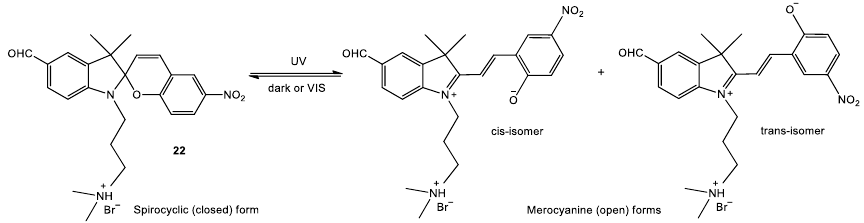
Figure 3. Spiropyran (SP) closed-ring structure and its stimuli-induced open-ring isomers (MC).